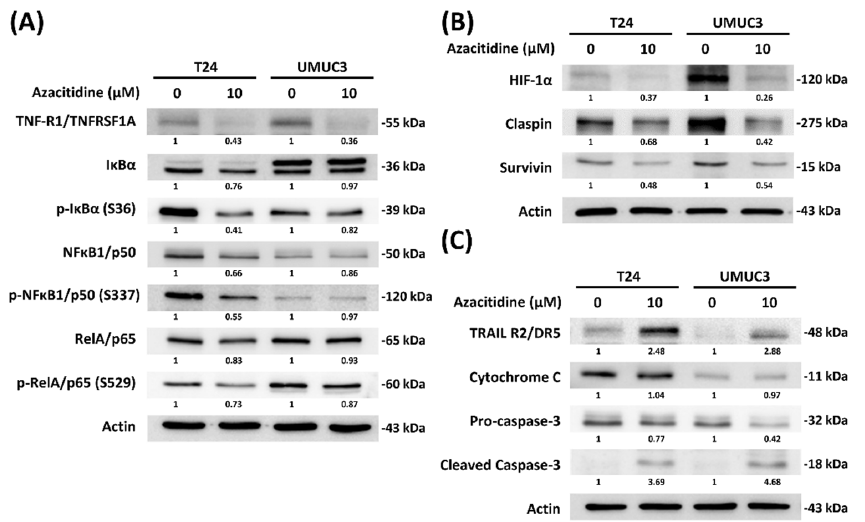
Figure 4. Azacitidine-facilitated apoptosis was associated with downregulation of the NF- κ B pathway and upregulation of the TRAIL R2 pathway. ( A ) Azacitidine suppressed NF- κ B-related protein expression in UBUC cells. ( B ) HIF-1 α , claspin, and survivin expression were inhibited after azacitidine treatment. ( C ) TRAIL-related protein changes were evaluated after azacitidine